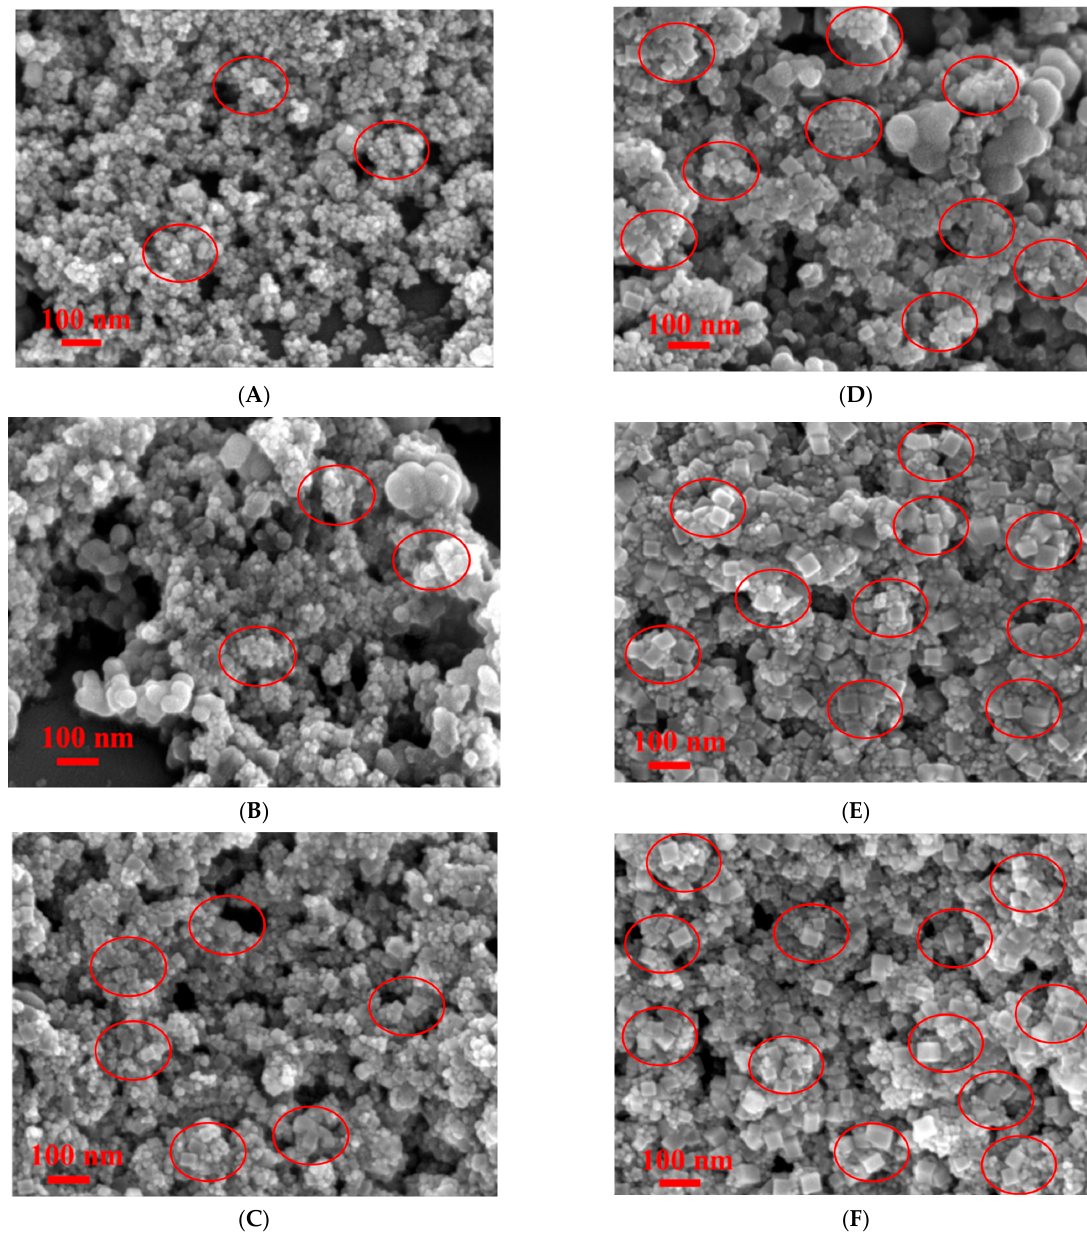
Figure 4. SEM images of SPCE/nano-Fe 3 O 4 /PBNC obtained from Solution I at different stages of synthesis. Potential scans, starting from +0.6 V, and ending at ( A ) +0.25 V, and ( B ) − 0.1 V. Potential scans, starting from +0.6 V, switching at − 0.1 V, and then ending at +0.6 V for ( C ) 1 ( D ) 2, ( E ) 3, and ( F ) 5 cycles. Red circle indicates the crystal size and shape. Thus, the reaction mechanism is proposed accordingly. As shown in Equation (5), the acidity from the acids (HX) causes a proton-promoted dissolution process from the solid/solution interface to the underlying nano-Fe 3 O 4 , especially in inorganic acids (HCl and H 3 PO 4 ). By introducing an organic acid, such as glyphosate or citric acid, which has a strong surface interaction with the surface nano-Fe 3 O 4 (noted as nano-Fe 3 O 4.... HX), the re- lease of iron ions can be slowed down. The redox reactions of the iron species are pre- sented as Equations (6) and (7). The iron precursors at the electrolyte/electrode interface